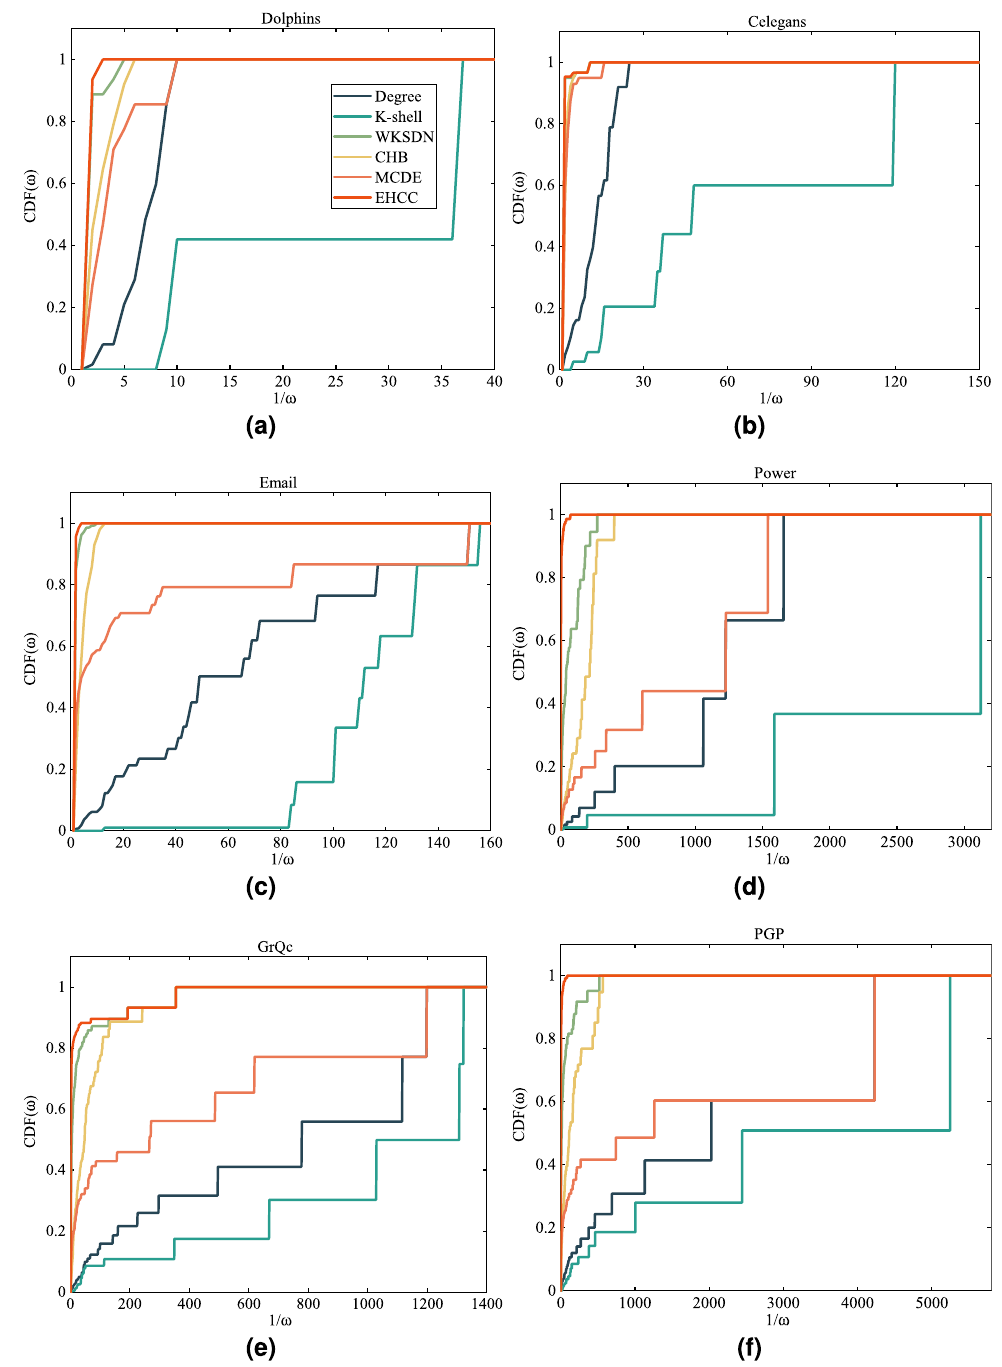
Figure 2. CDF (The cumulative distribution function) of different algorithms in six real networks. ω is the identity of the nodes. ( a )–( f ) are the networks Dolphins, Celegans, Email, Power, GrQc and PGP